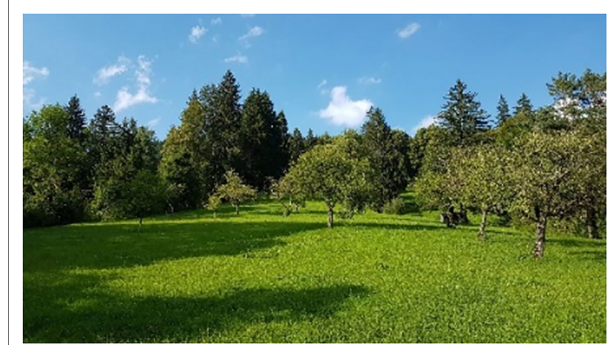
FIGURE 1 | The meadow image shown for 40 s between the baseline and post-intervention SARTs in Studies 1 and 2.